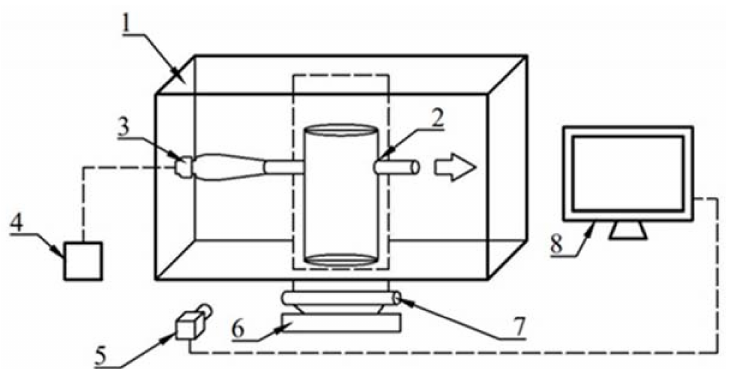
Figure 4. Scheme of the PIV test stand: 1—aquarium, 2—model of the tested apparatus, 3—submersible (jet) pump, 4—flow controller, 5—camera, 6—LED lamp, 7—light blade lens,